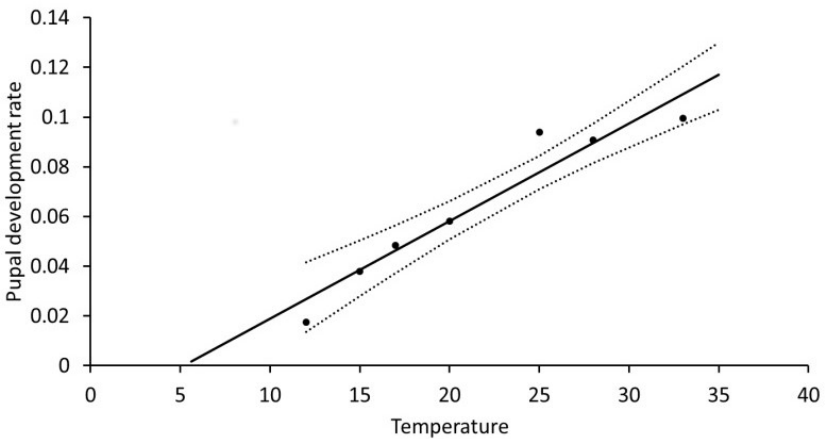
Figure 3. Temperature dependent development of Agrotis segetum pupae) at seven different temperatures; R pupa = 0.1886 + 0.0039T (°C), R 2 = 0.947, p = 0.0002. Both sexes are involved, as no statistical difference was found between the two sexes. The dashed lines above and below represent the upper and lower 95% confidence bands.